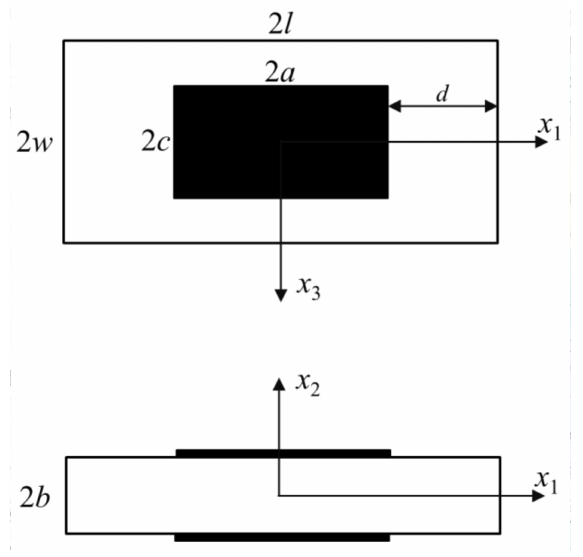
Figure 1. A rectangular partially electroded quartz resonator: plane view and cross